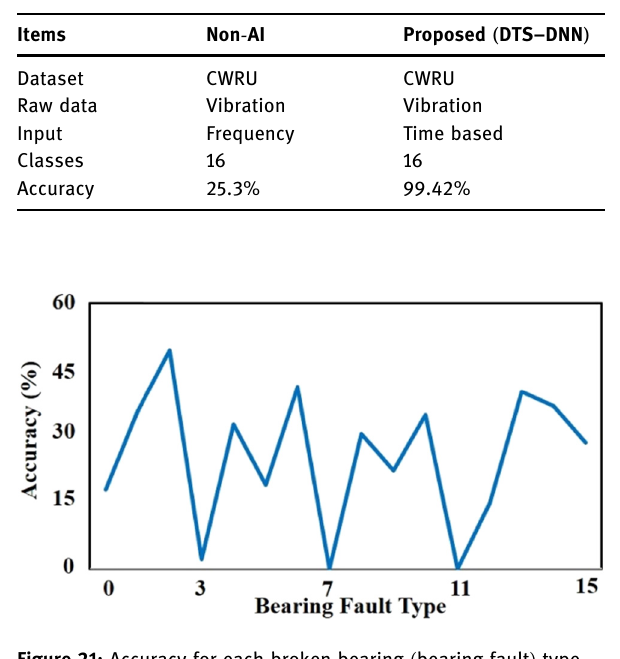
Figure 21: Accuracy for each broken bearing ( bearing fault )